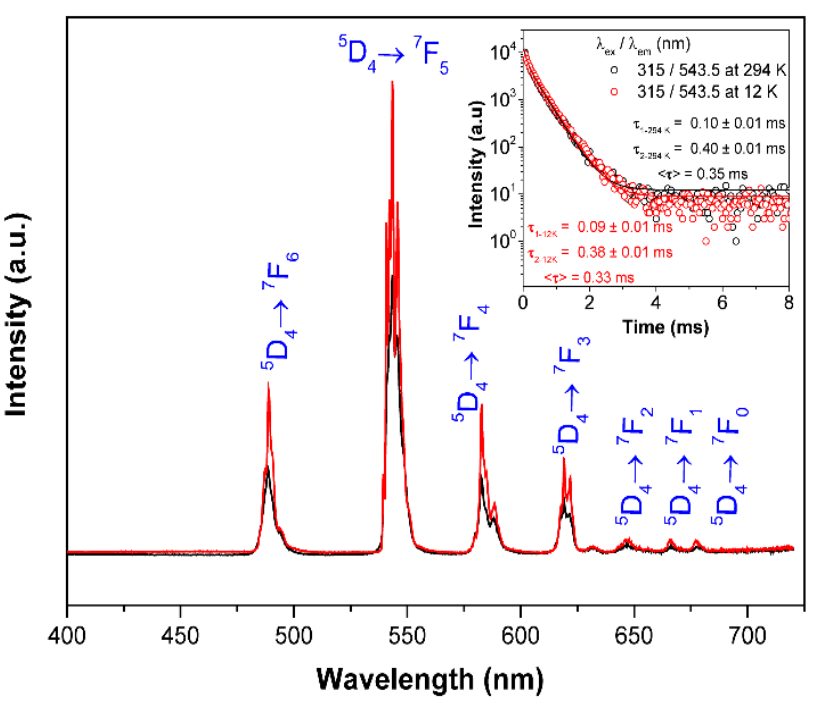
Figure 8. Emission spectra of 1@PMMA recorded at 294 K (black) and 12 K (red), with the excitation fixed at 315 nm. Inset: 5 D 4 decay curves of 1@PMMA acquired at 294 K (black) and 12 K (red), monitoring the Tb 3+ emission at 544.5 nm with the excitation fixed at 315 nm. The solid lines are the best fits using second order exponential decay function; y = y 0 + A 1 ·exp( − x/ 𝜏 1 ) + A 2 ·exp( − x/ 𝜏 2 ) (r 2 > 0.999).